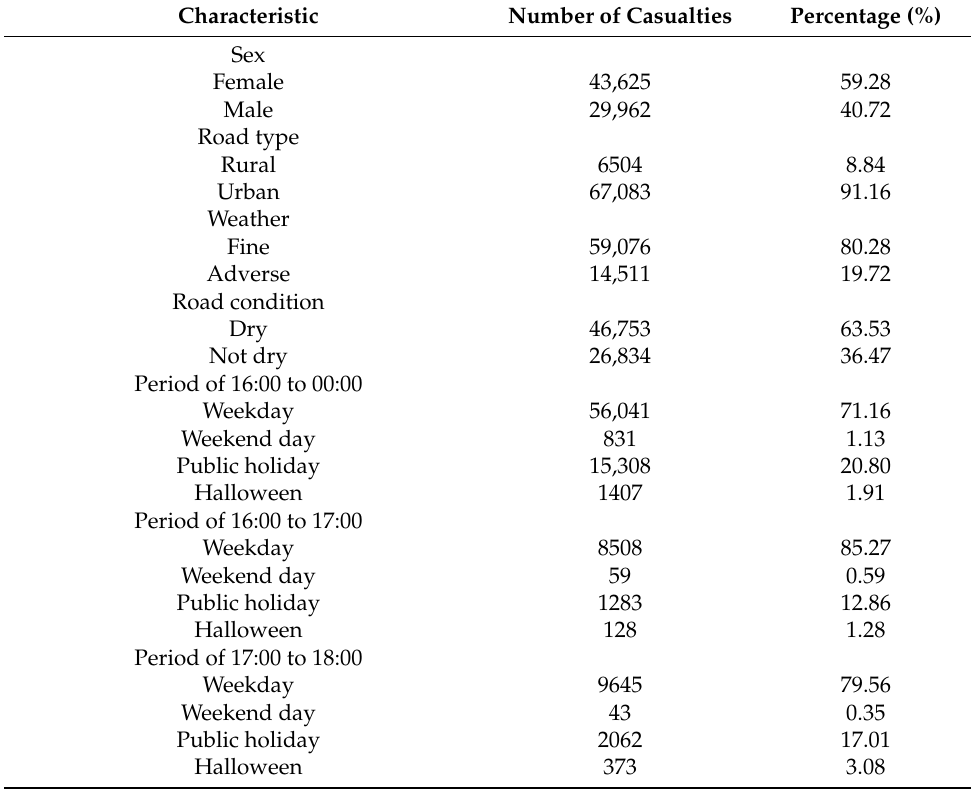
Table 1. Characteristics of casualties from 1990 to